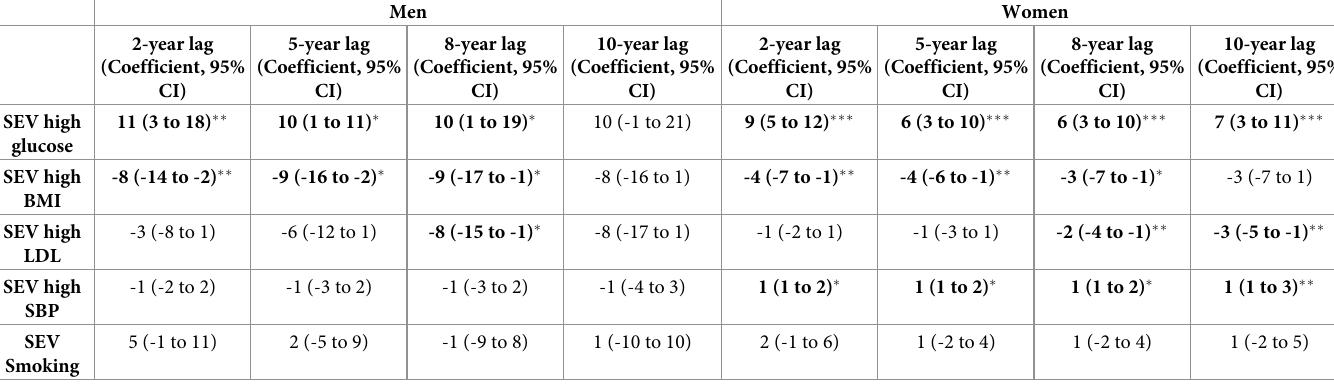
Table 2. Lag-time analysis between the summary exposure value (SEV) for risk factors and mortality by cardiovascular diseases (CVD) in men and women, Brazil, 2005 to 2017.